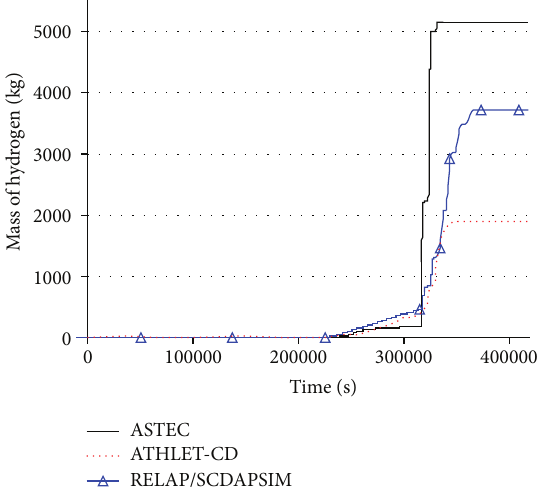
Figure 12: Hydrogen generation calculated by different